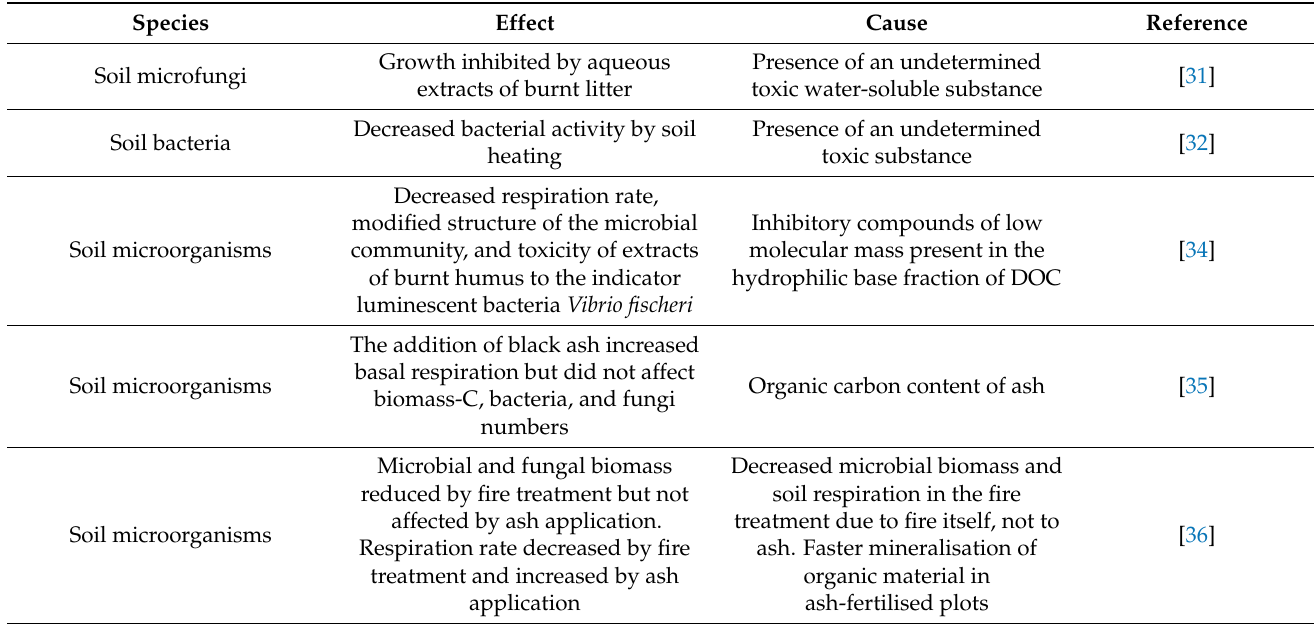
Table 2. Effects of ash or burning on soil